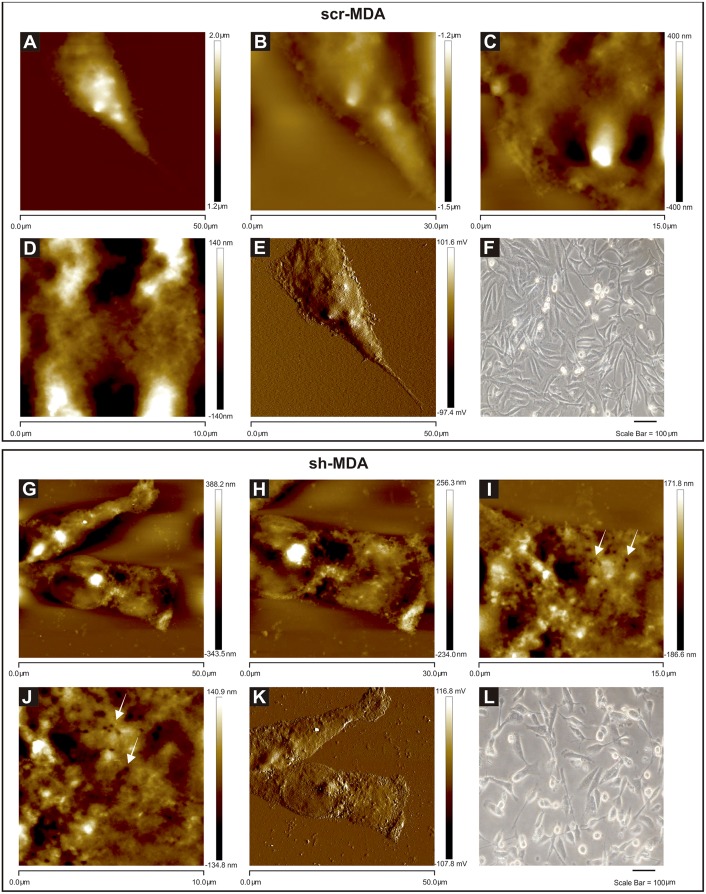
Optical microscopy and AFM images of scr-MDA and sh-MDA cells.AFM images were obtained in tapping topography (A-D for scr-MDA and G-J for sh-MDA) and amplitude modes (E for scr-MDA and K for sh-MDA). Fig 4A presents topographical parameters of a complete scr-MDA cell. Fig 4E presents amplitude image. Fig 4G presents topographical parameters of complete sh-MDA cell, and Fig 4K presents amplitude image. Parameters of the pictures are 50.0 μm x 50.0 μm (Fig 4A, E, G and K); 30.0 μm x 30.0 μm (Fig 4B and H); 15.0 μm x 15.0 μm (Fig 4C and I); 10.0 μm x 10.0 μm (Fig 4D and J). All images have a resolution of 512 x 512 pixels. The height of the cell is expressed in color scale (right bar). White arrows in Figs 4I and J indicate pore-like structures. Optical images (Fig 4F and L) have a magnification of 200x.